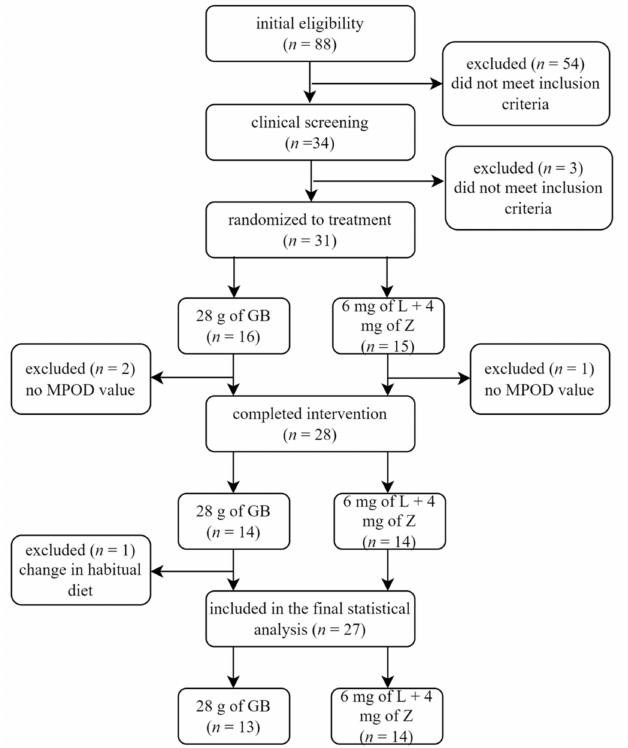
Figure 1. Participant flow diagram. Thirty-one participants were randomly assigned to consume either 28 g of goji berries (GB) or a supplement containing 6 mg of lutein (L) and 4 mg of zeaxan- thin (Z), five times per week for 90 days. Twenty-eight individuals completed the study. An n = 13 in the GB group and an n = 14 in the LZ group were used in the statistical